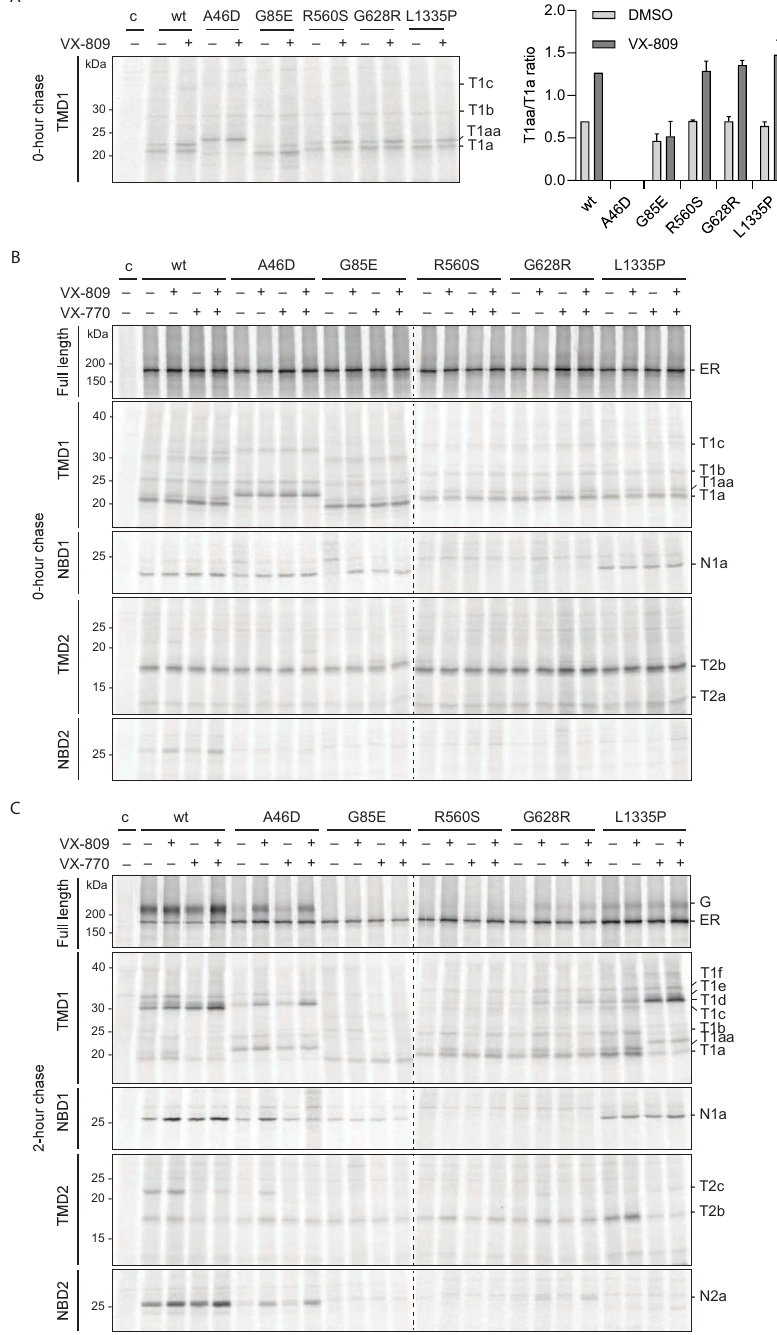
Figure 4. Modulator-specific conformational changes are visible in hypo-responder mutants ( A ) HEK293T cells expressing wild-type and mutant CFTR were radiolabeled for 15 min. Where indicated, VX-809 (3 µ M) was added during the starvation, pulse, and chase. Detergent lysates were treated with 100 µ g/mL proteinase K and immunoprecipitated using TMD1-specific antibody E1-22. Quantification of TMD1 T1a and T1aa fragments at 0 h chase, as in Figure 3C. ( B ) CFTR was analyzed as in Figure 3A. The top panel shows undigested CFTR and the lower panels show domain-specific fragments immunoprecipitated after digestion with 25 µ g/mL proteinase K. ( C ) As in ( A ), but radiolabeled CFTR was chased for 2 h. Gels are representative of three repeats. Lane profiles of wild-type and A46D TMD1 fragments are shown in Figure S3C. Lane profiles of wild-type and L1335P NBD2 fragments are shown in Figure S3D. Data are used for plots